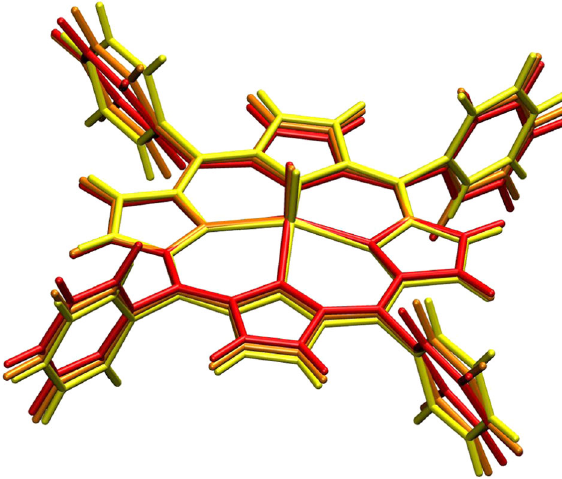
Fig. 6 | [VO(TPP)] molecular distortions. Two different degrees of molecular distortion associated with the fi rst optical mode at the Γ -point are represented in red (large distortion) and orange (small distortion) colours. The yellow structure corresponds to the equilibrium molecular structure.